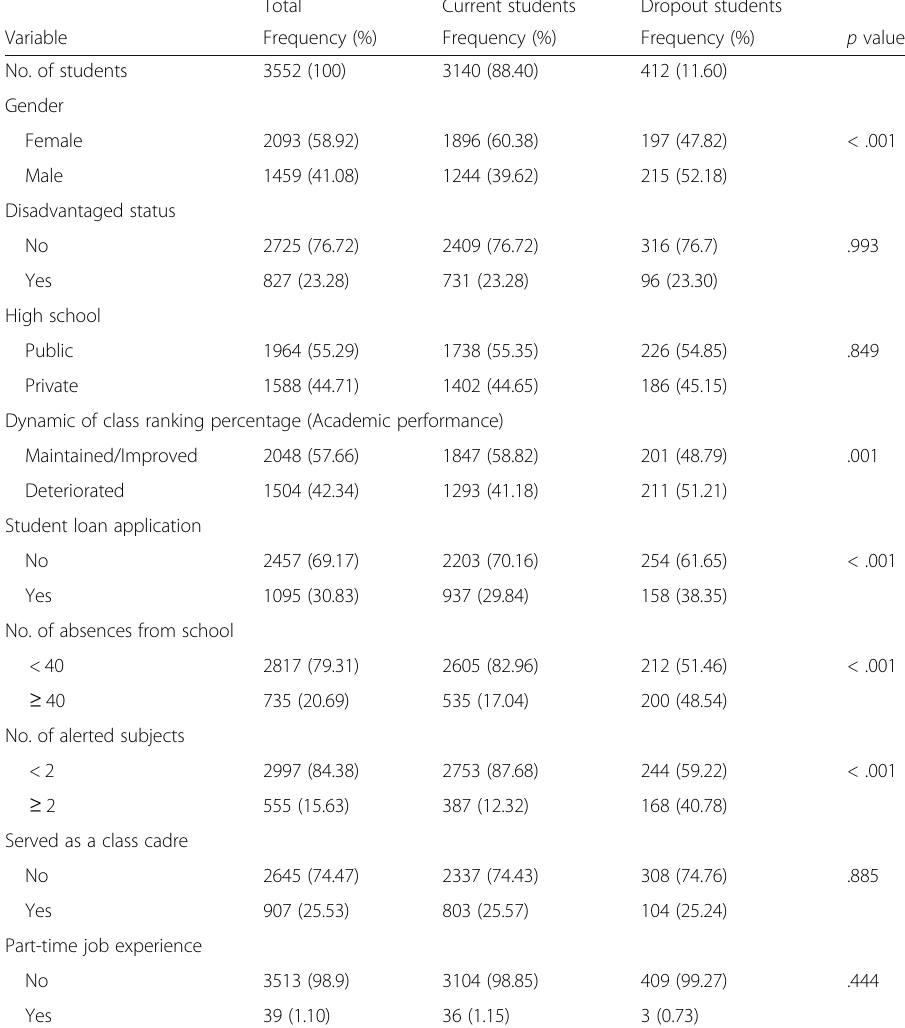
Table 1 Background information of students